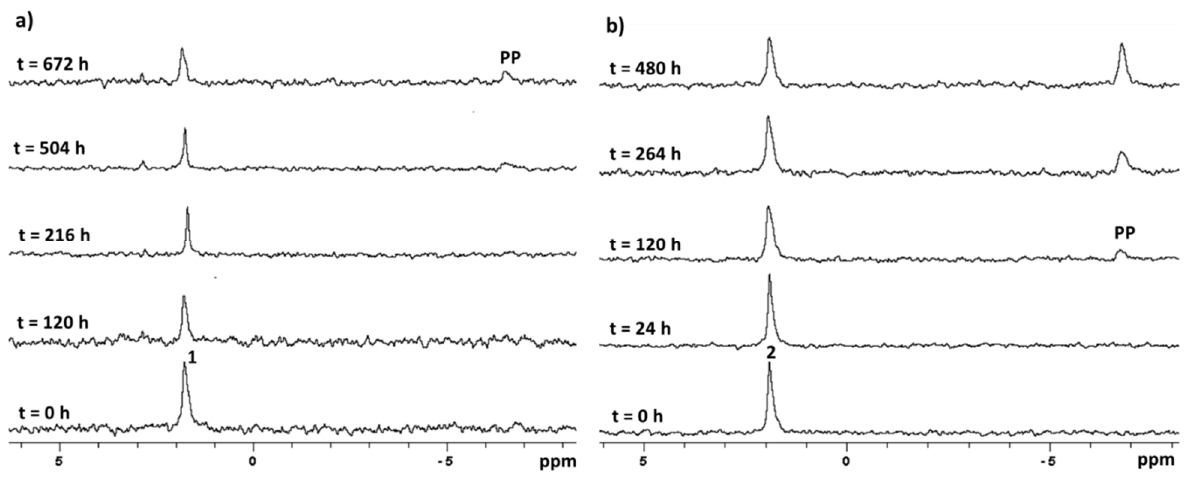
Figure 6. 31 P NMR (121.5 MHz) spectra at different times of 1 ( a ) and 2 ( b ) in physiological conditions (D 2 O, HEPES buffer 50 mM, pH* = 7.4, 120 mM NaCl, 37 °C).